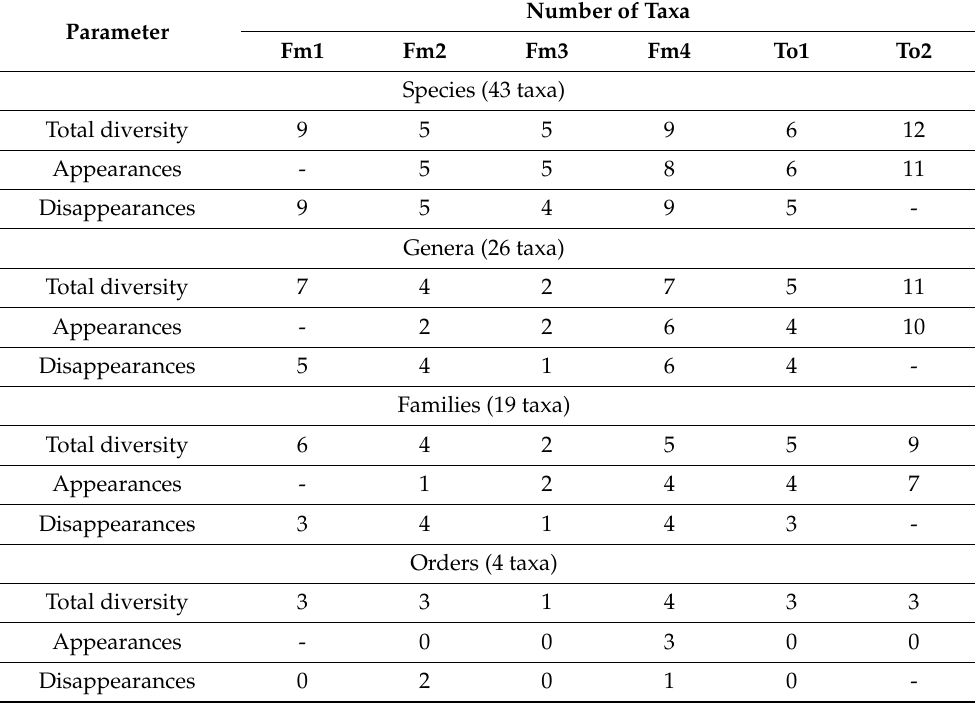
Table 1. Taxonomic diversity of the studied